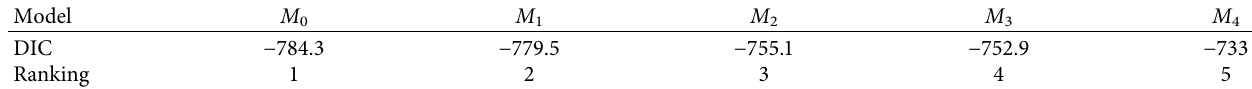
Table 2: Comparison of different models.